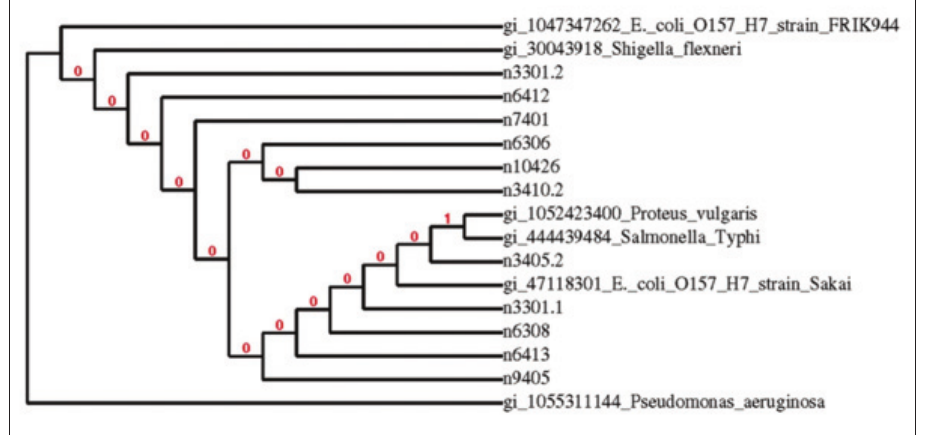
Figure-2: Phylogenetic tree was constructed using neighbor-joining algorithm of partial 16S rDNA nucleotides sequence showing phylogenetic relationships between the sequences of the local Escherichia coli isolates sequences and E. coli O157:H7 (Sakai and FRIK944 strains) available in databanks.